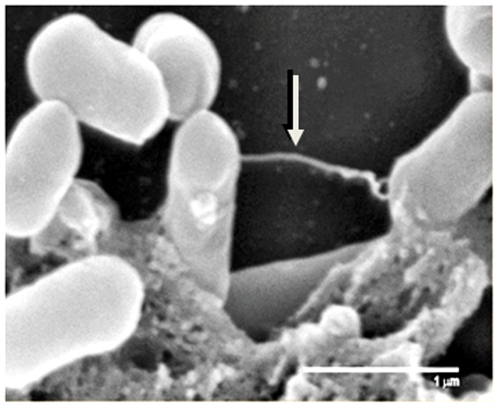
Scanning electron microscope image of listeria and extracellular material.
L. monocytogenes strain 10403S was embedded within the extracellular material. The arrow is pointing to a strand of extracellular material between the bacteria. Scale bar represents 1 µm.